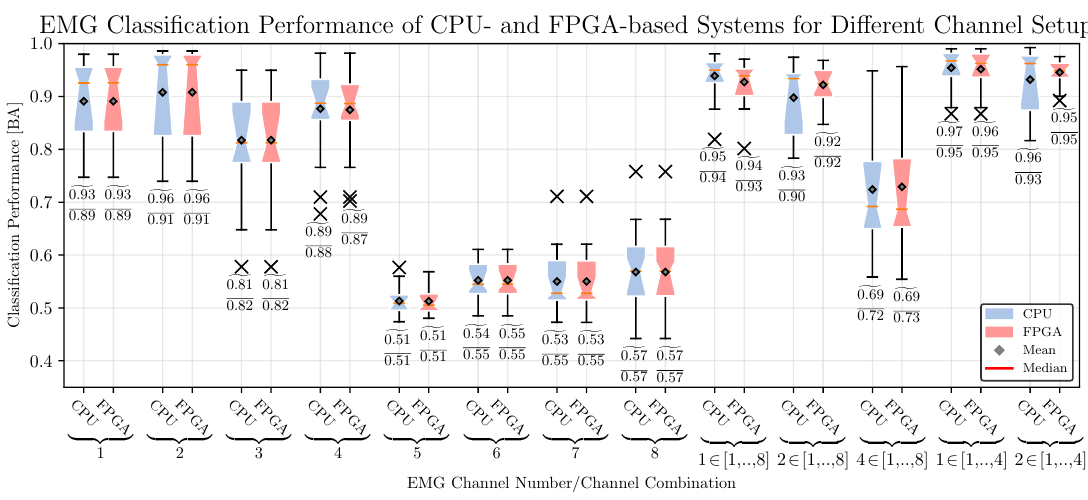
Figure 6. Classification performance for the prediction of movements based on the EMG. The median BA ) and mean ( BA ) classification performance is reported for each ( (cid:102)